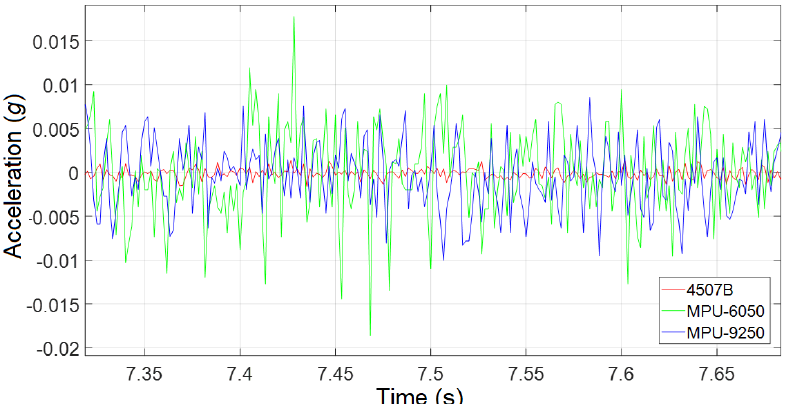
Figure 6. Comparison of the responses registered by the accelerometers at rest.